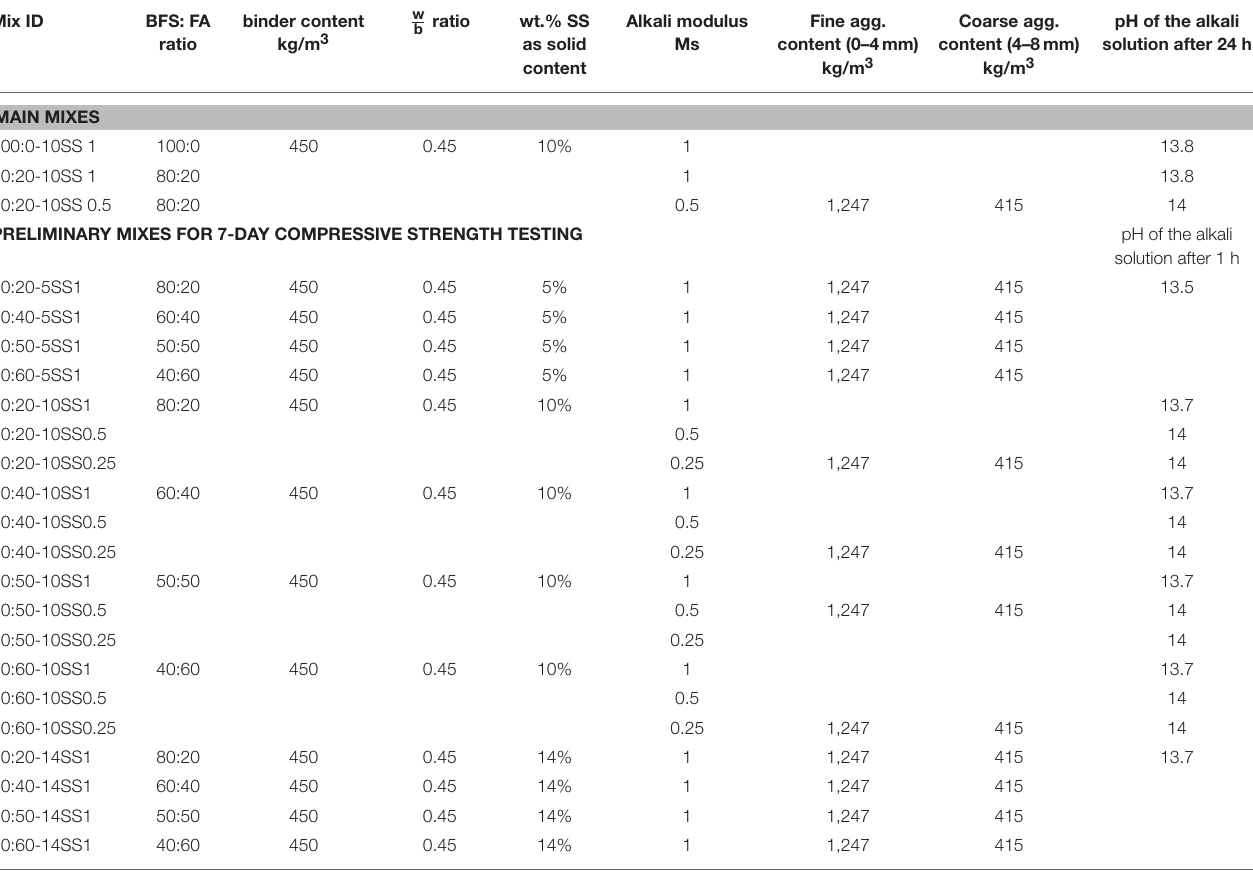
TABLE 3 | Mix properties of